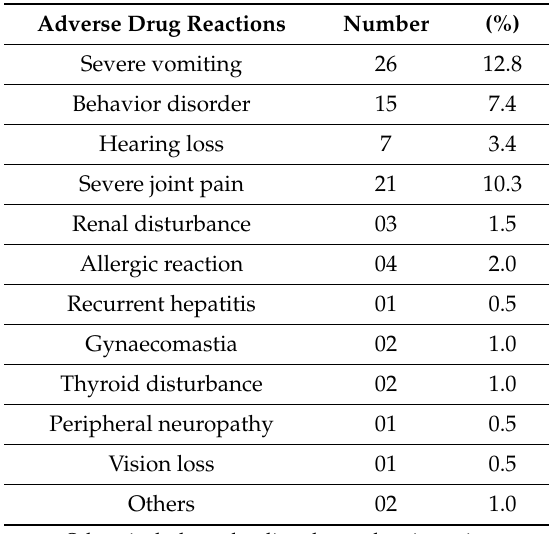
Table 2. Adverse drug reactions among drug-resistant extrapulmonary TB cases in Delhi in 2016 ( n =